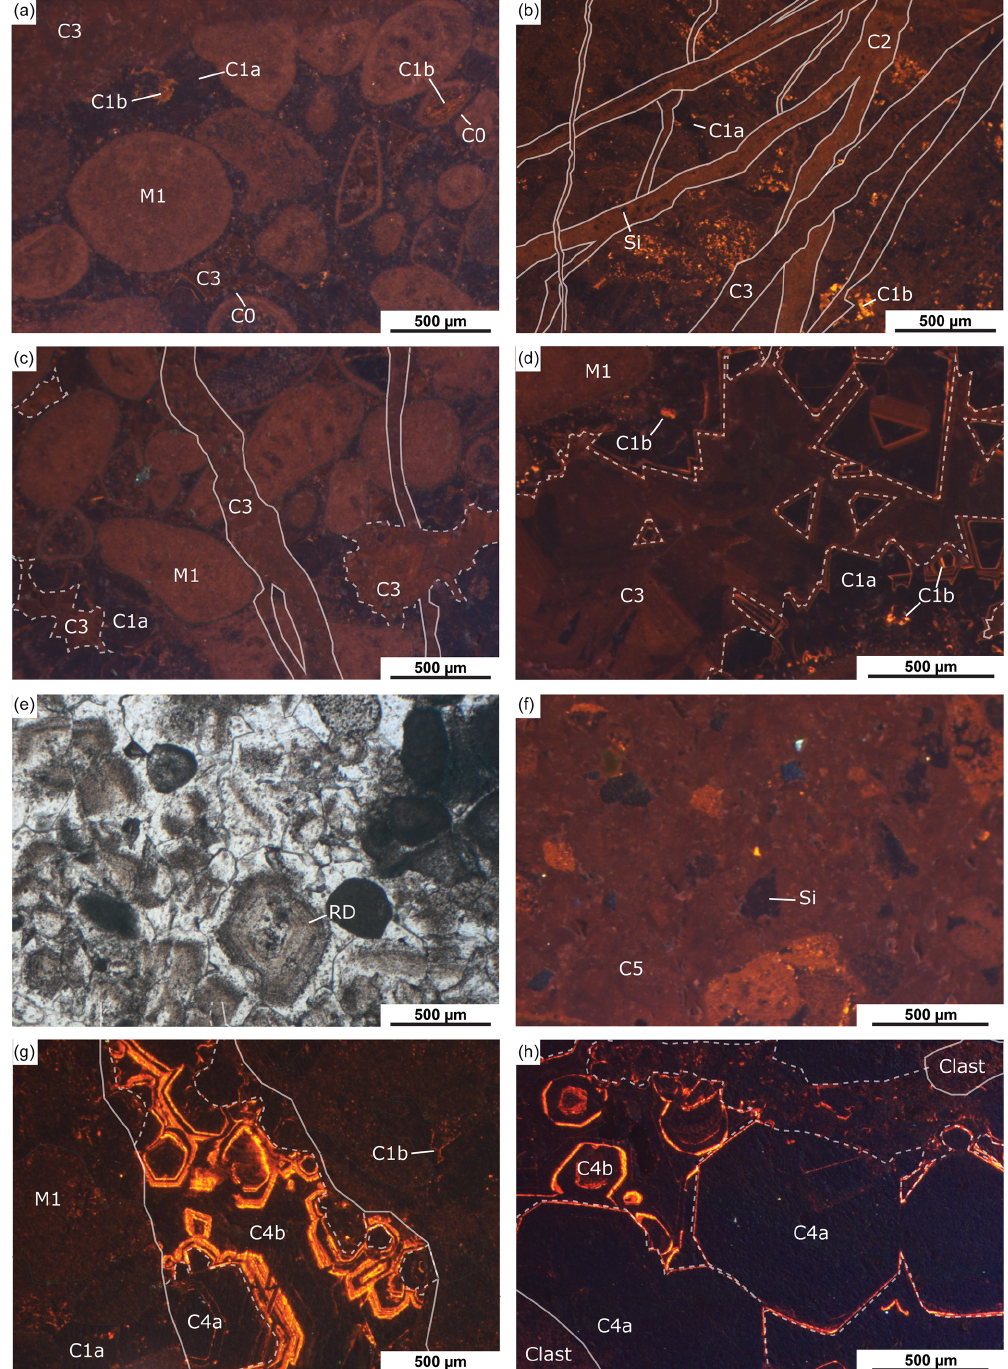
Figure 5. Thin sections under cathodoluminescence. (a) Calcarenite in transect 3 with micritized grain (M1) and intergranular volume cemented with C1a and b and C3; (b) C2 (with Si) and C3 veins affecting Castellas FR1 clasts with micritized grains cemented by C1b; (c) C3 veins, cements, and intergranular volumes in Castellas Fault zone; (d) C1 ( a and b ) and C3 cementing moldic porosity of transect 3 calcarenite; (e) FR1 matrix with phantom of cloudy appearance replacive dolomite (RD); (f) FR1 matrix dedolomitized by C5 containing quartz grains; (g) C4 ( a and b ) cementing vein of D19 Fault zone; (h) matrix of D19 FR2 cemented by C4 ( a and b ). C3 is a blocky calcite with non- to red-dull luminescence in veins, moldic, and intergranular pores ( b–d ). This cement also occurs in few veins of D19 sectors but is not restricted only to the fault